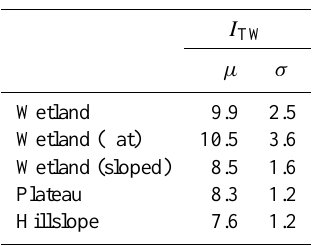
Table 4. Mean and standard deviation of the topographical wetness index ( I TW ) for each landscape class